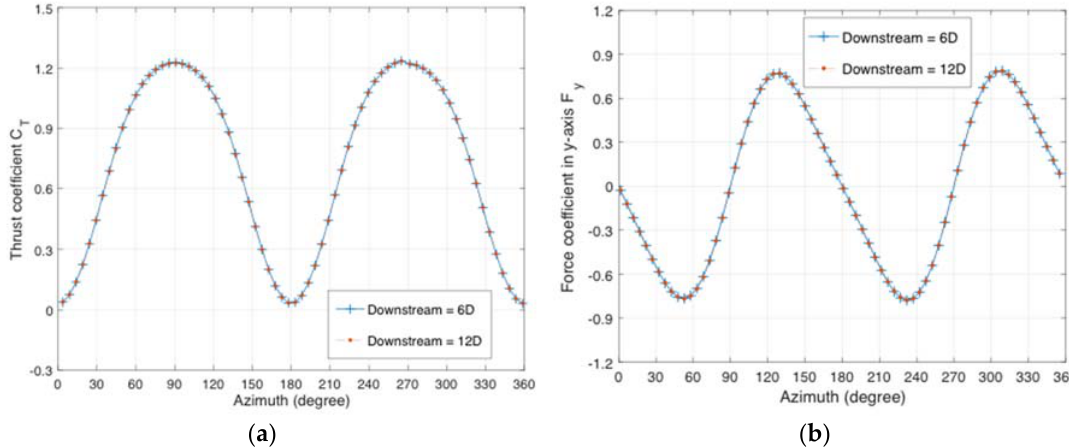
Figure A4. Comparison of predicted force coe ffi cients obtained on meshes of downstream length 6 D and 12 D , for TSR = 3.3 as functions of azimuthal angle: ( a ) thrust coe ffi cient C T ; and ( b ) lateral force coe ffi cient F y .